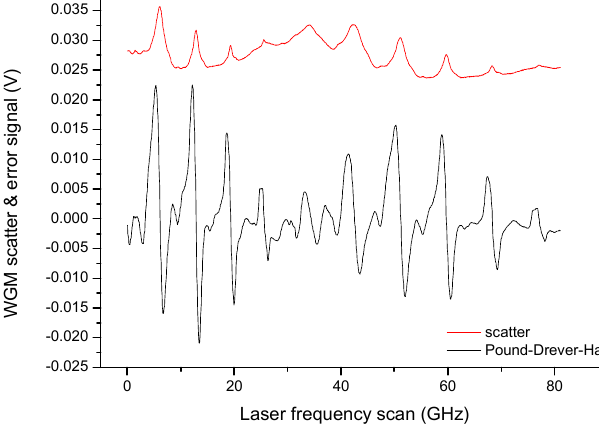
Figure 5. Laser light coupling, detection and frequency locking scheme. D1, D2, photodetectors; RF, radio-frequency; AM, amplitude modulation; MZ, Mach–Zehnder modulator; L, lens (Reproduced with permission from [27]).